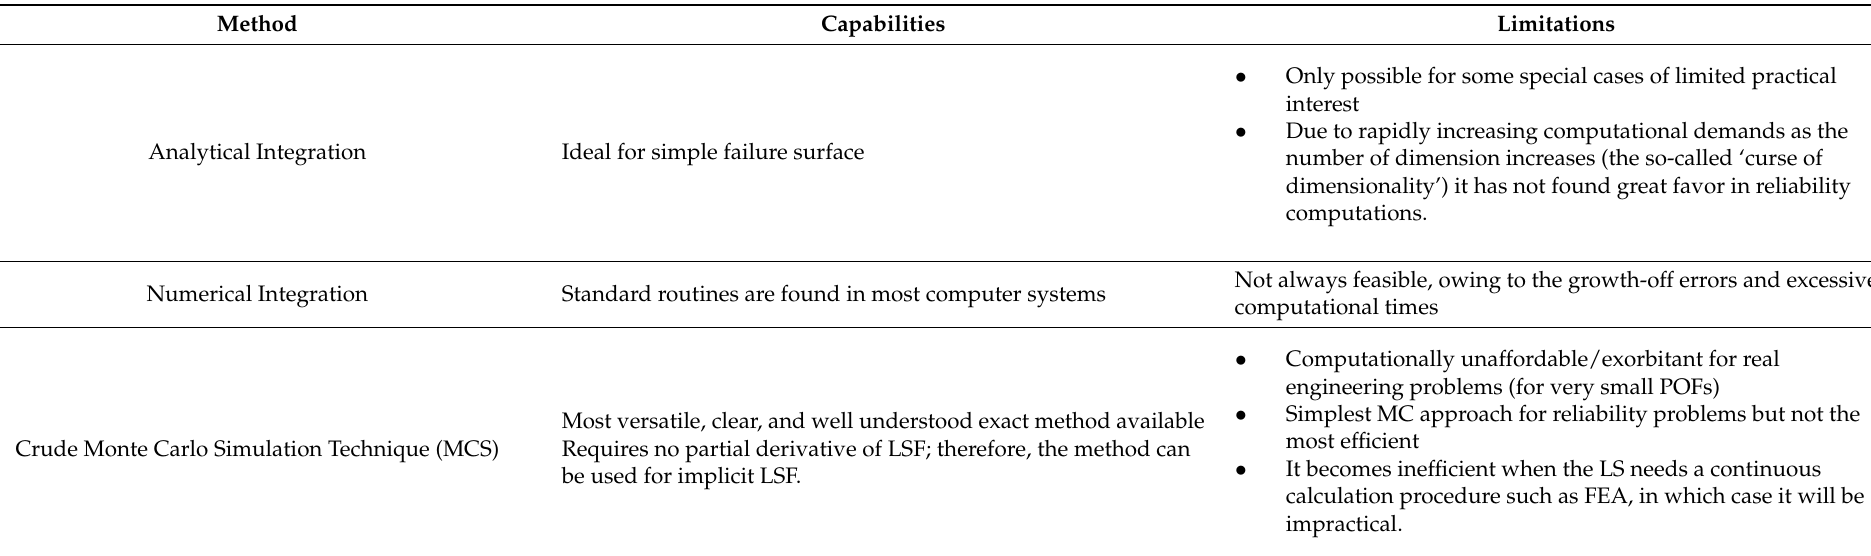
Table 2. Capabilities and limitations of the most common level III direct structural reliability